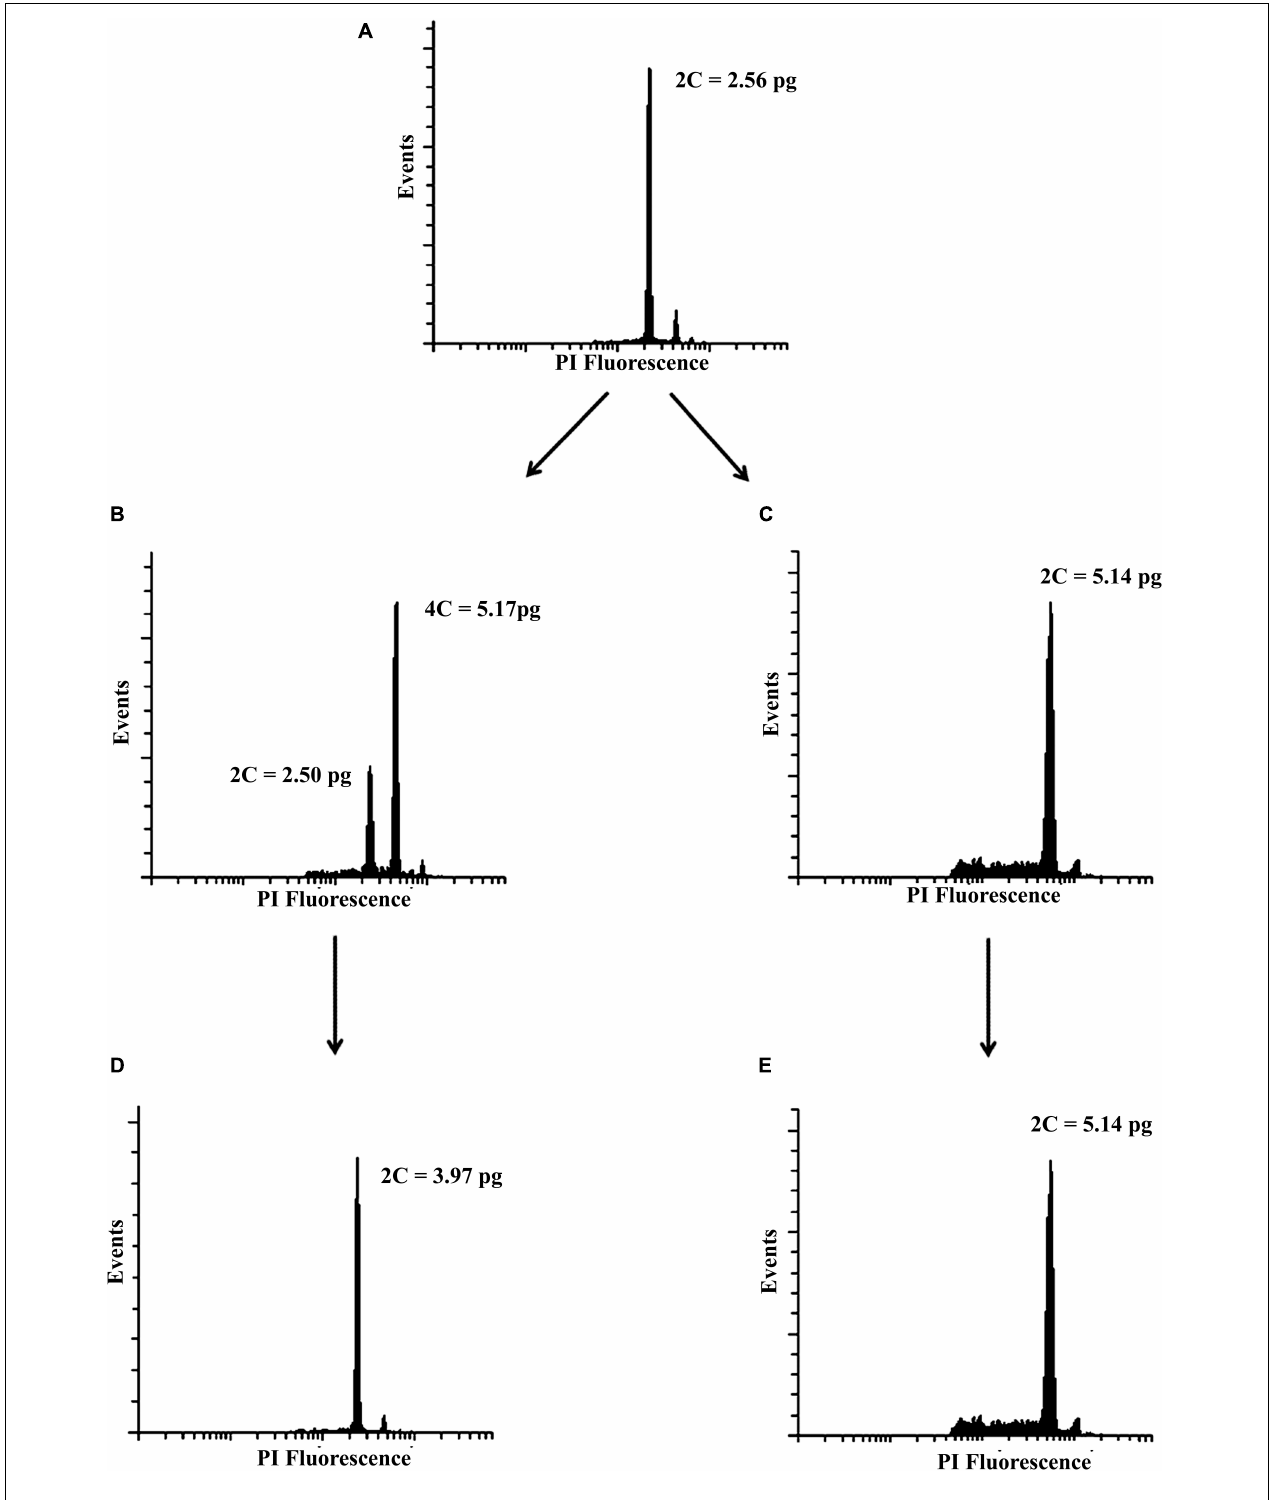
FIGURE 1 | Representative histograms of the mother plant and synthetic polyploids. (A) mother plant (diploid), (B) mixoploid, (C) tetraploid 40 days after polyploidy induction, (D) triploid, and (E) tetraploid acclimatized in the greenhouse.